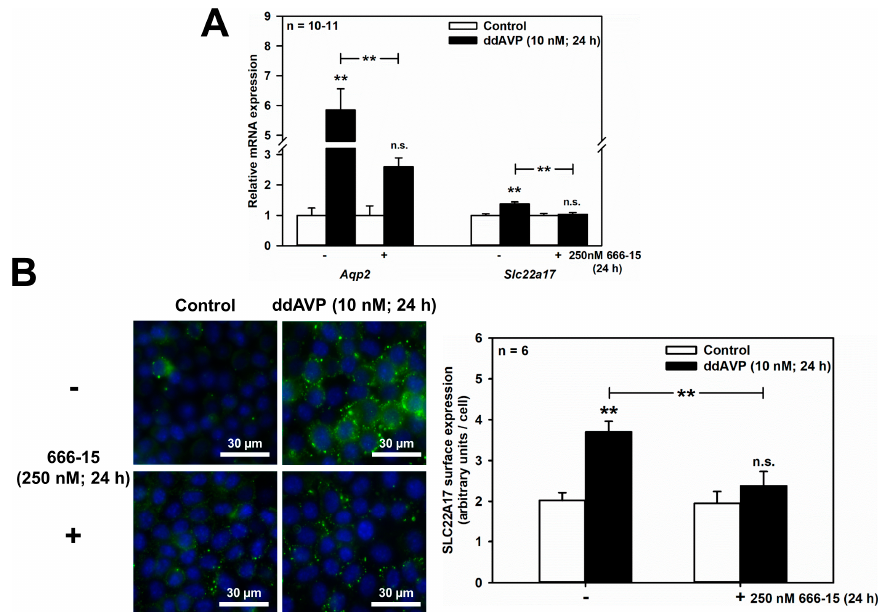
Figure 4. ddAVP increases Slc22a17 / SLC22A17 expression through CREB activation in mCCD(cl.1) cells. ( A ) Expression levels of Aqp2 and Slc22a17 mRNA by qPCR, in cells treated with ddAVP ± the